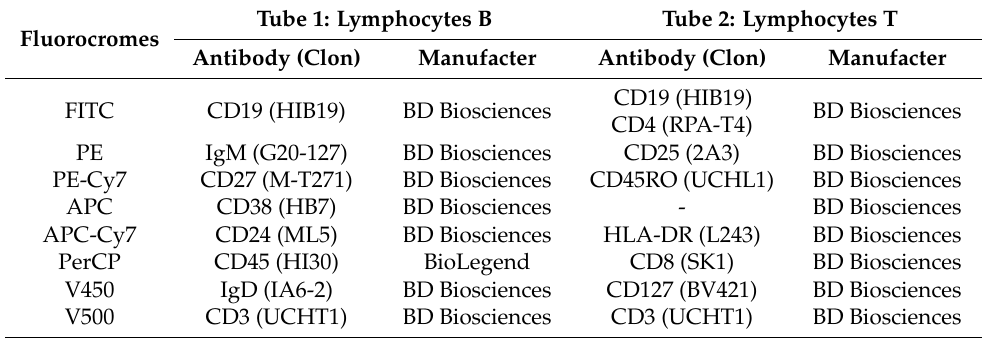
Table 3. Antibodies panel to monitoring T and B cells subtypes by flow